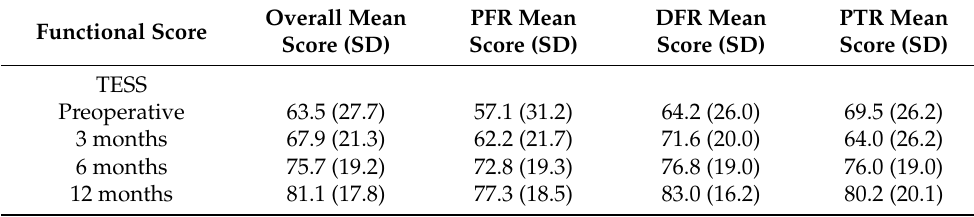
Table 2. Functional outcome scores over